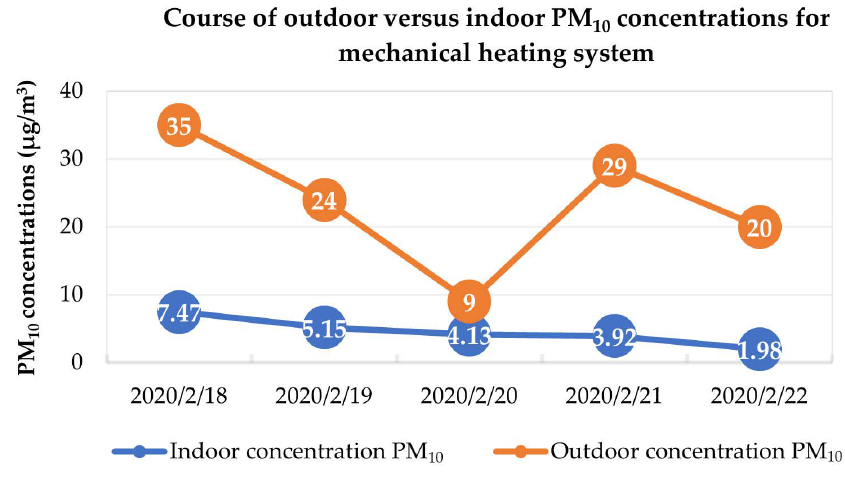
Figure 19. Courses of outdoor versus indoor PM 10 concentrations for MHS